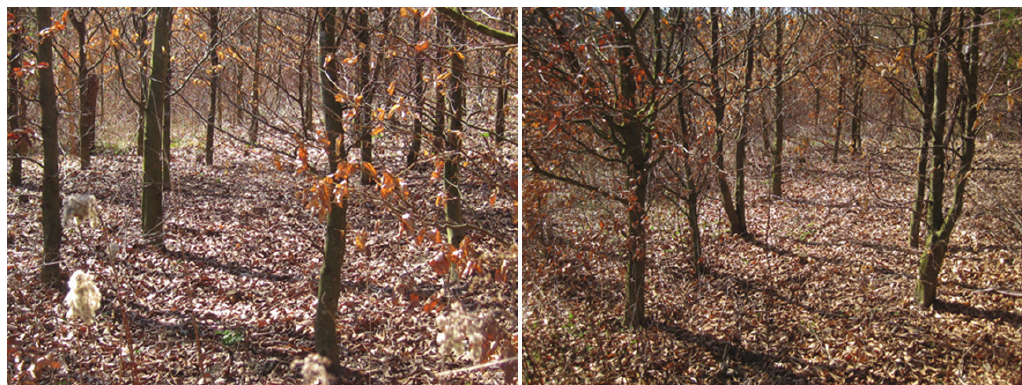
fIGUre 3. In addition to growth and survival, stem quality of provenances is an important trait. Left: Farchau (D) with an excellent stem form. Right: Farkasgyepű from Hungary presumably shows the effect of dysgenic selection in the